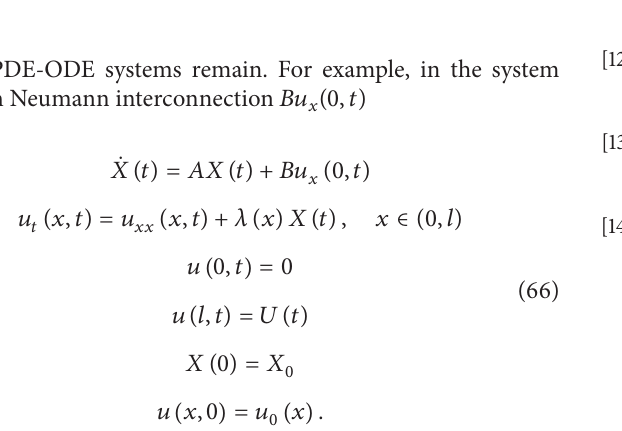
Figure 2: Trajectory of the state 𝑢(𝑥,𝑡)